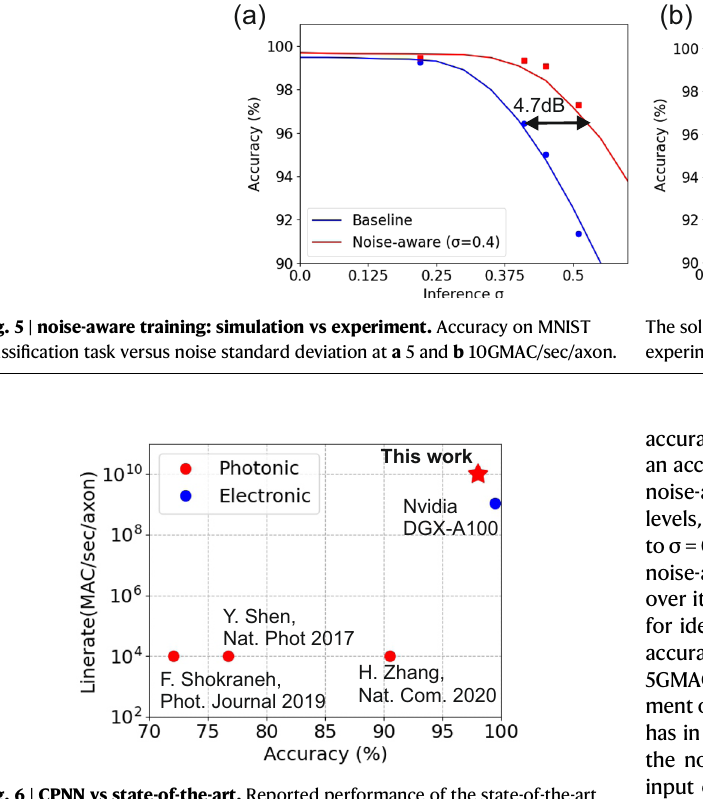
Fig. 6 | CPNN vs state-of-the-art. Reported performance of the state-of-the-art Nvidia DGX-A100 and few experimentally demonstrated coherent linear neuron engines in terms of line rate and classi fi cation